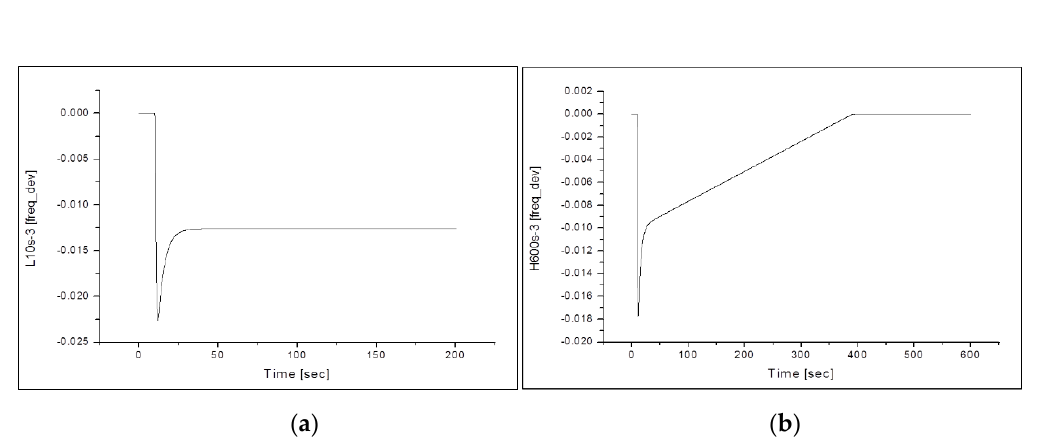
Figure 15. Frequency deviation of the load fluctuation (all steel company, summer): ( a ) GF responsive characteristics (light load 10 s-3 σ ); ( b ) AGC responsive characteristics (heavy load 600 s-3 σ ).